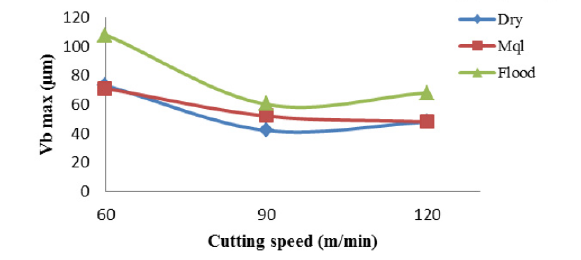
Figure 4: Effect of cutting speed on flank wear in ceramic tools [34]